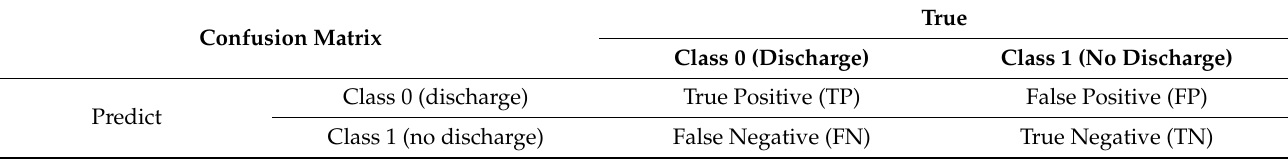
Table 3. Binary-class confusion